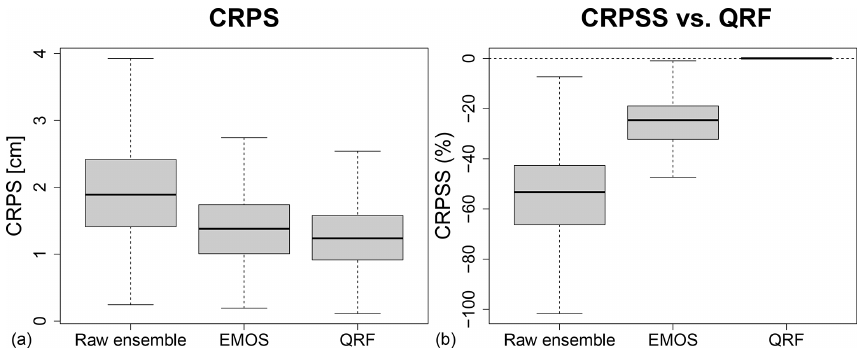
Figure 5. Box plots of CRPS (a) and relative CRPS with QRFs as a reference (b) , with the different methods and for all locations, for a 1d lead time.